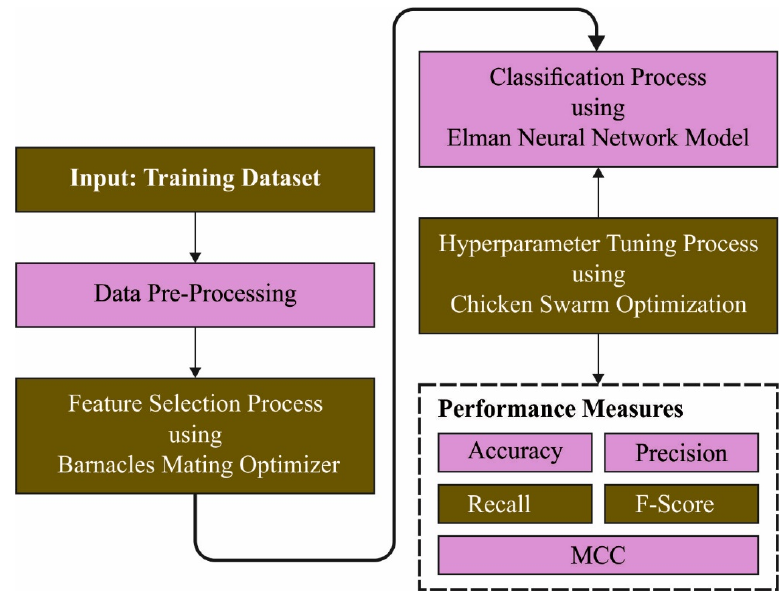
Figure 1. Block diagram of BND ‐ BMOML approach.